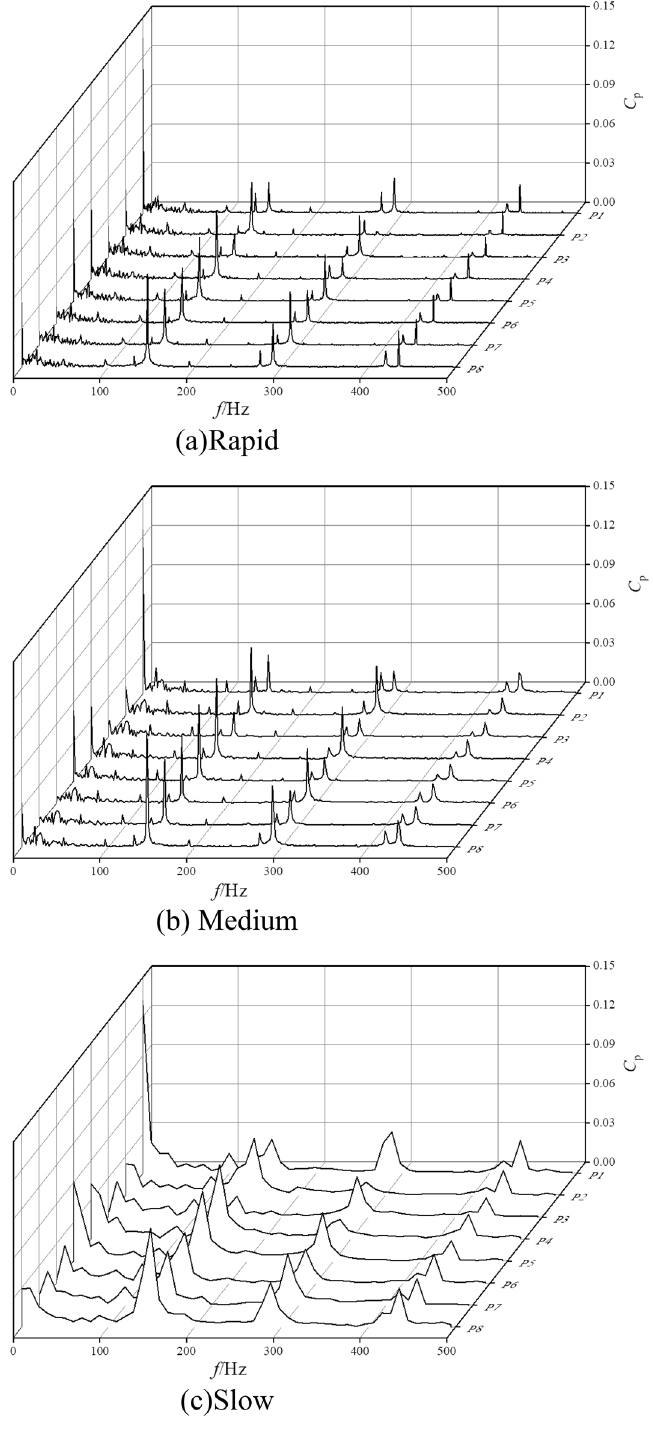
Figure 15. Frequency domain diagram of different monitoring positions in the worm shell. ( a ) Rapid, ( b ) Medium, ( c )